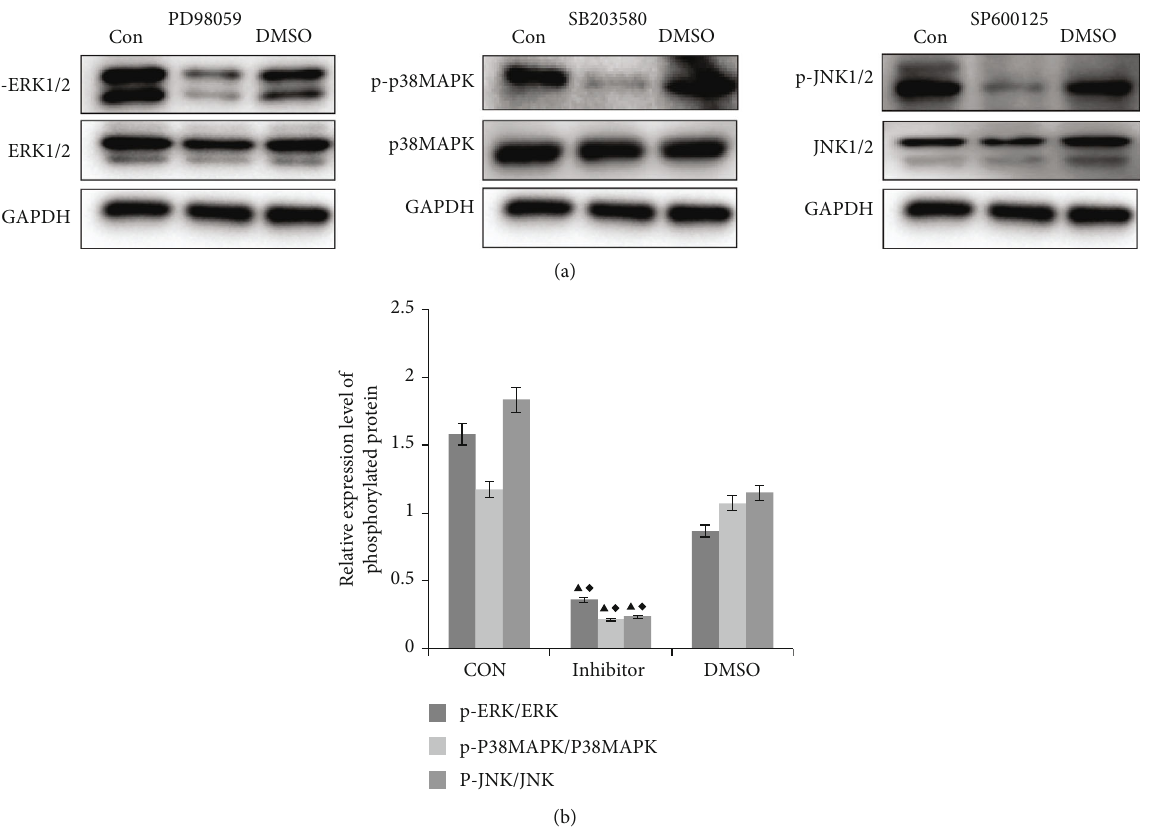
Figure 7: MAPK pathway inhibitors PD98059, SB203580, and SP600125 prevent AGE-induced activation phosphorylated ERK protein, p38MAPK, and JNK in EPCs, respectively. EPCs were pretreated with PD98059 (50 μ mol/l), SB203580 (20 μ mol/l), or SP600125 (50 μ mol/l) for 1h, then stimulated with AGE (100 μ g/ml) for 5min. Untreated and DMSO-treated samples were used as the controls. (a) Total protein and phosphorylated ERK, p38, and JNK levels and GAPDH were measured by western blot. (b) Phosphorylation-to- total protein expression ratios of ERK, p38, and JNK are presented. Each data point represents the results of three independent experiments. Comparison with control, ▲ P < 0 : 05 vs.; comparison with DMSO, ◆ P < 0 : 05 vs. AGE: advanced glycation end product; Con: control; EPC: endothelial progenitor cell; p-: